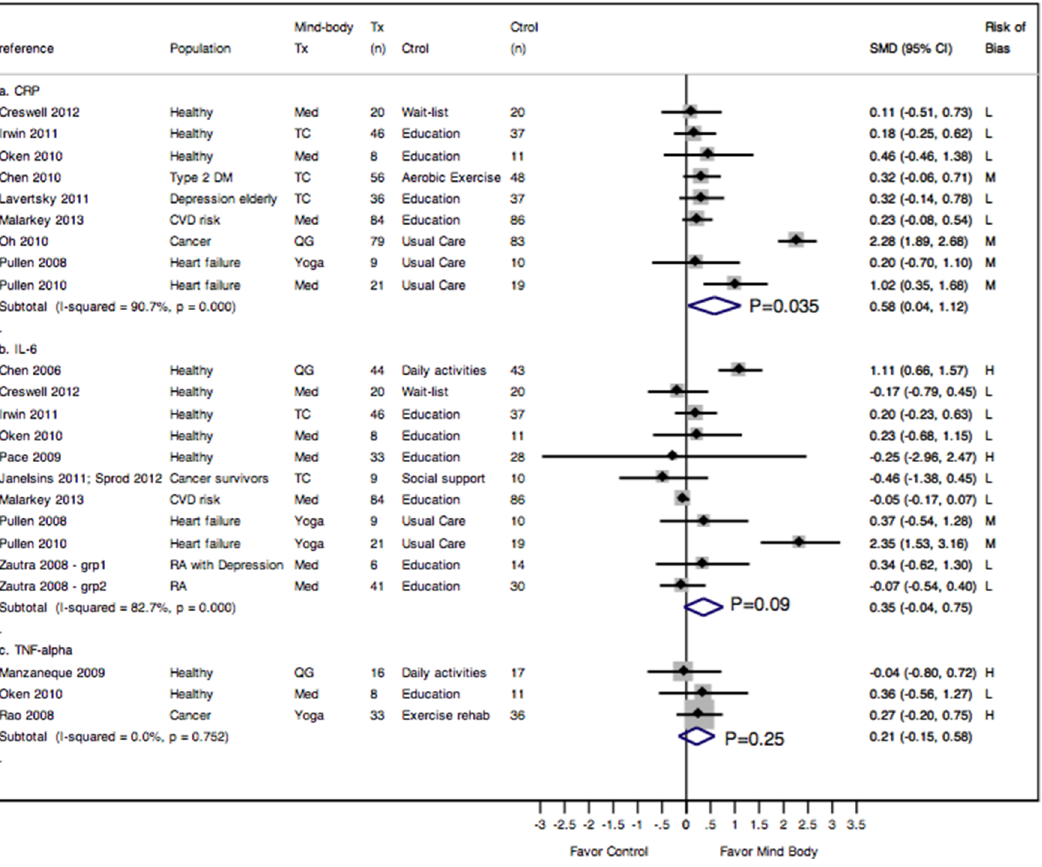
Figure 2. Meta-analysis of RCTs comparing the effect of mind-body therapies with control interventions on inflammatory markers: CRP (panel a), IL-6 (panel b), and TNF- a (panel c). Legends: CRP=c-reactive protein; IL-6=interleukin 6; Med=meditation; QG=Qi Gong; TC=Tai Chi; TNF- a =Tumor necrosis factor; Tx=treatment; RA=rheumatoid arthritis; SMD=standardized mean difference. Risk of bias: L=low; M=medium; H=high (see Table S2 for details). Zautra 2008 reported only subgroup results (grp 1=RA patients with depression; grp 2=RA patients without depression) and data from each subgroup were entered in the meta-analysis separately. P-values adjacent to I-squared results are p-values for heterogeneity testing (P , 0.05 indicates significant heterogeneity), and p-values adjacent to meta-analysis pooled results (diamonds) are p-values for the pooled effect sizes.